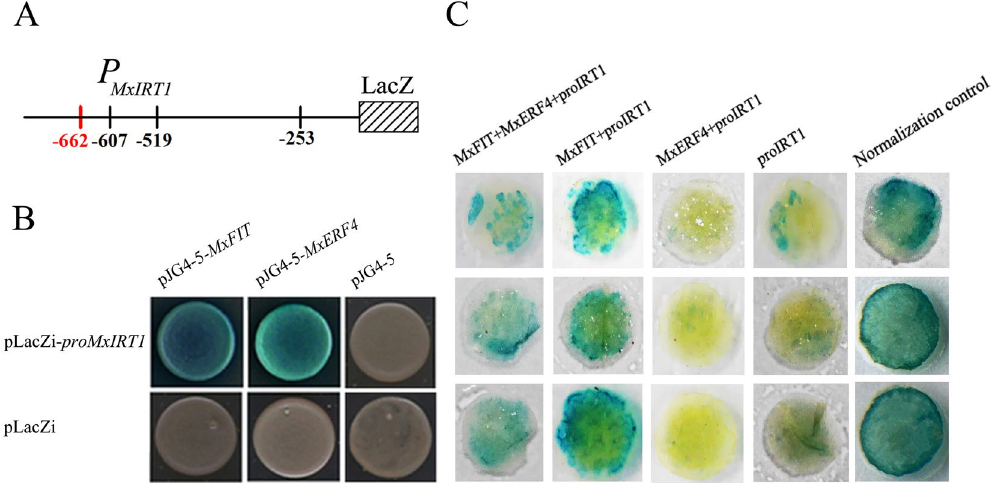
Figure 5. MxERF4 bind the promoter of MxIRT1 and suppress the effect of MxFIT on MxIRT1 . (A) The structure of the MxIRT1 promoter (765 bp) showing three GCC-box motifs ( − 253 bp, − 519 bp and − 607 bp, in black), one G-box ( − 662 bp, in red). (B) Yeast one hybrid analysis of MxERF4 and MxFIT with the MxIRT1 promoter. All tests were conducted on minimal medium/-Trp,-Ura. Interactions were determined based on cell growth and were confirmed by an X-gal assay on minimal medium/-Trp,-Ura. (C) The effect of MxFIT and MxERF4 on MxIRT1 promoter. GUS staining of reprentative leaf pieces infiltrated with normalization control (pCAMBIA1301) or only promoter ( MxIRT1 ) or coinfiltrated with the transcriptional factor and the promoter (MxFIT + MxERF4 + proMxIRT1 , MxFIT + proMxIRT1 , MxERF4 + proMxIRT1